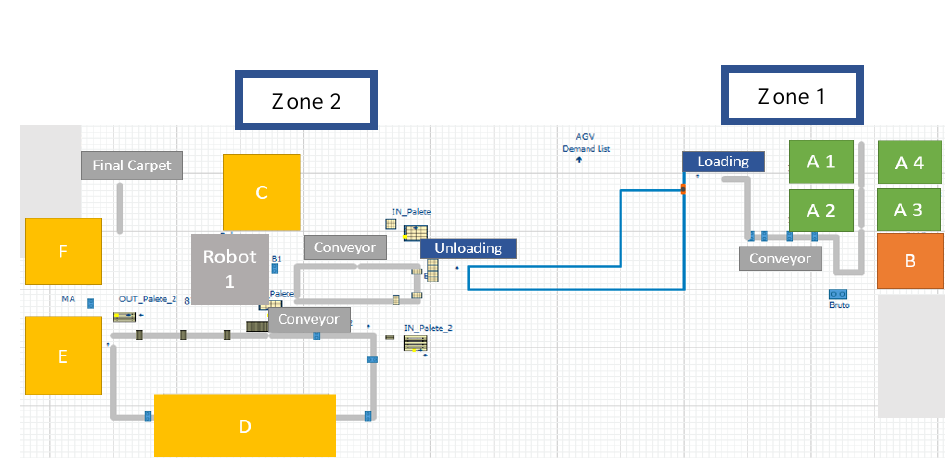
Figure 5. Layout 3 (Machine A and Machine B in Zone 1).